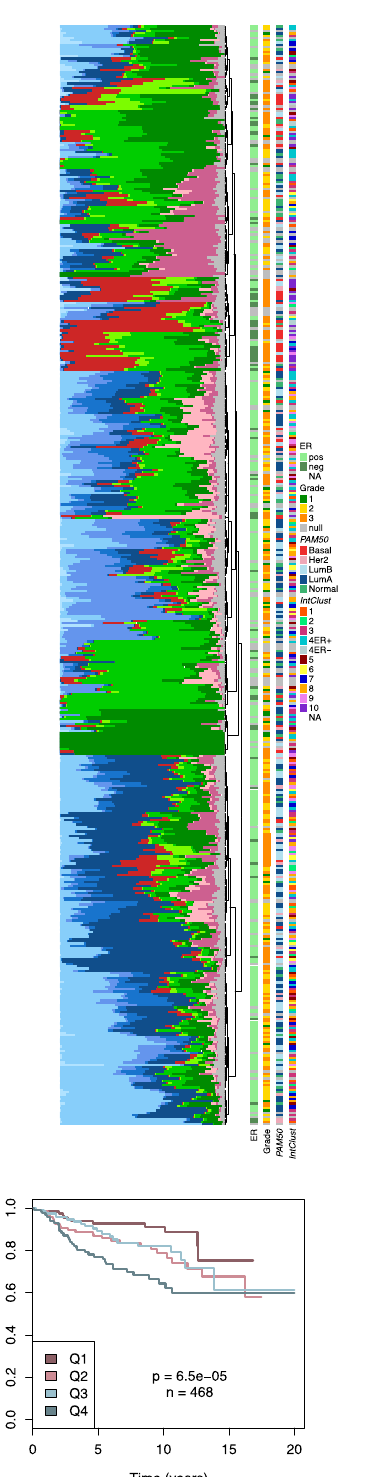
Fig. 7 Xenograft cell phenotypes mapped onto primary human tumours. a Barplots summarising the prevalence of each of the 11 human CCs in 481 METABRIC cases analysed by IMC. Samples are ordered based on hierarchical clustering of phenotypic pro fi les. Molecular data in vertical bars to the right. b Kaplan – Meier curves by quartile of values predicted with a regularised Cox model fi tted to associate the phenotypic pro fi le (as CC prevalence log ratios) with patients ’ survival. DEFS distant event-free